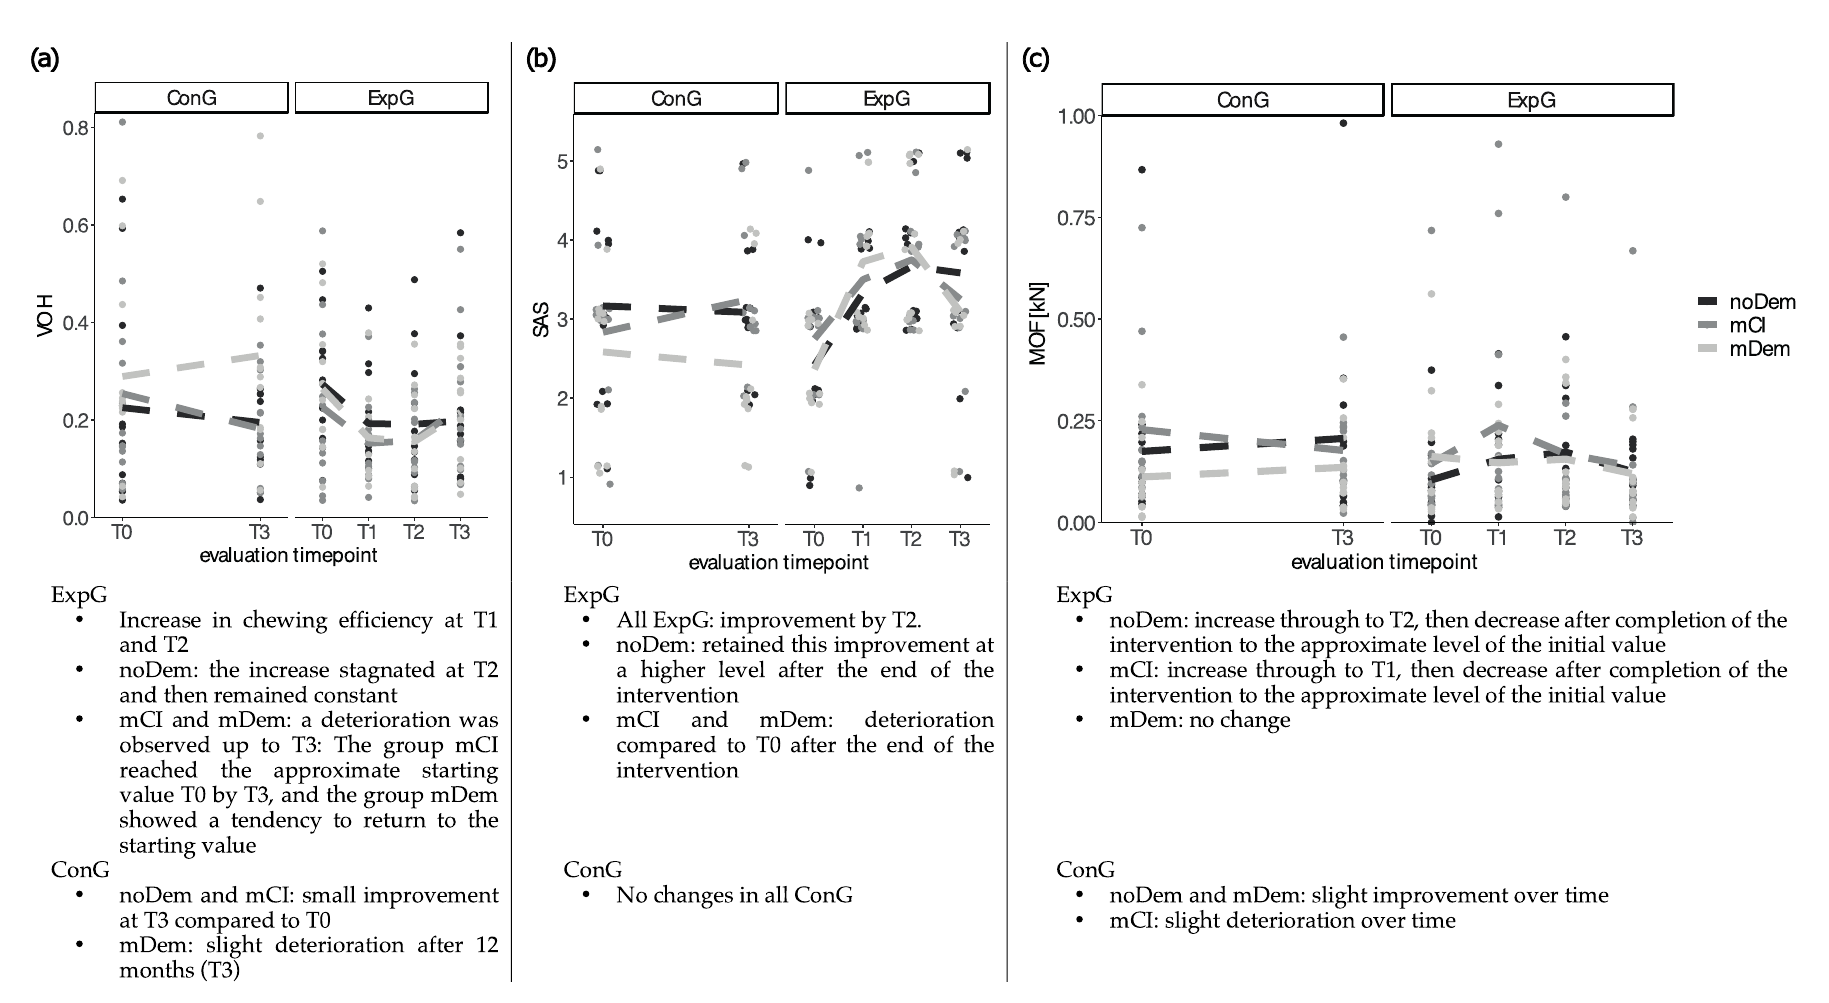
Figure 1. Visualization of changes in ( a ) chewing efficiency (Variance of Hue, VOH), ( b ) chewing efficiency subjective assessment scale (SAS) and ( c ) maximum occlusal force (MOF in kN) over time (evaluation timepoints T0–T3 (T0—baseline, T1—3 months and T2—6 months after starting the intervention (experimental group only), T3—12 months after T0)); (noDem—no dementia, mCI—mild cognitive impairment, mDem—mild dementia, ConG—control group, ExpG—experi- mental group). The different colored dots correspond to the individual measurements per subgroup (noDem, mCI and mDem). The short lines illustrate the changes of the individual subgroups in the mean over